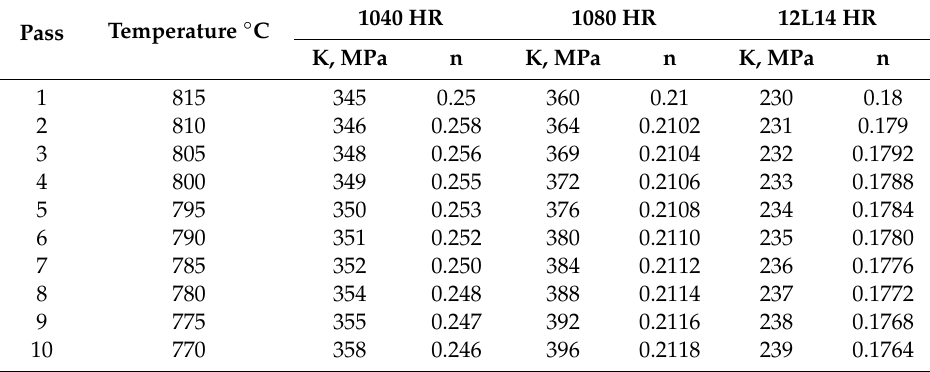
Table 2. Rolling parameters at 10 passes for 3 di ff erent HR steel materials.